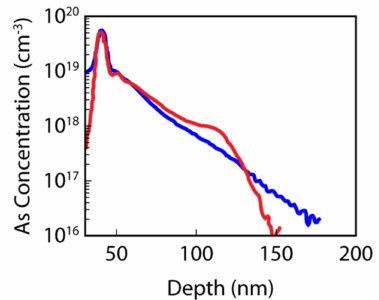
Figure 7. Arsenic concentration profiles with respect to depth for As-doped (blue line 3 × 10 13 As/cm 2 with 50 keV implantation energy) and F + As codoped (red line As: 3 × 10 13 As/cm 2 with 50 keV implantation energy; F: 1 × 10 15 F/cm 2 with 35 keV implantation energy)